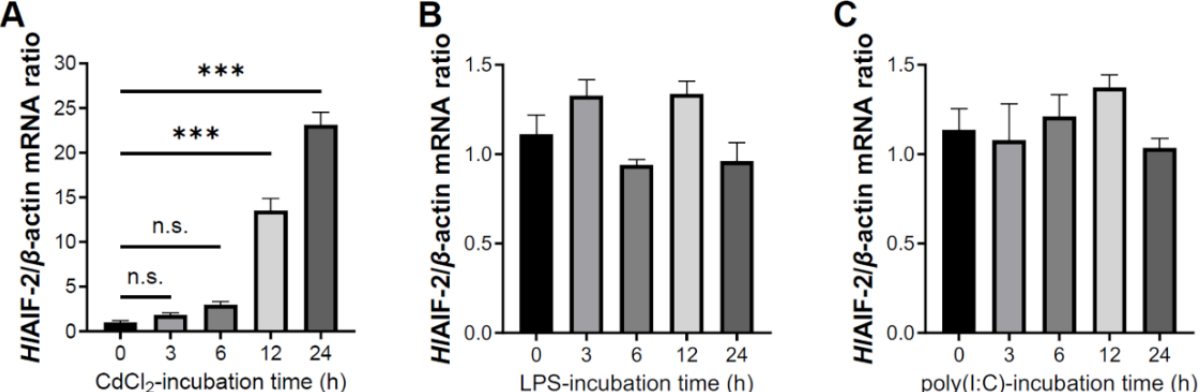
Figure 4. Expression analysis of HlAIF-2 after treatment of different exogenous stimulants. ( A – C ) Temporal expression pattern of Hl AIF-2 after treatment of CdCl 2 (20 µ M), LPS (10 µ g/mL) smf poly (I:C) (10 µ g/mL). Data are presented as mean ± SE ( n = 3), and significant differences are analyzed using one-way ANOVA, and shown as n.s. p > 0.05 and *** p < 0.001.